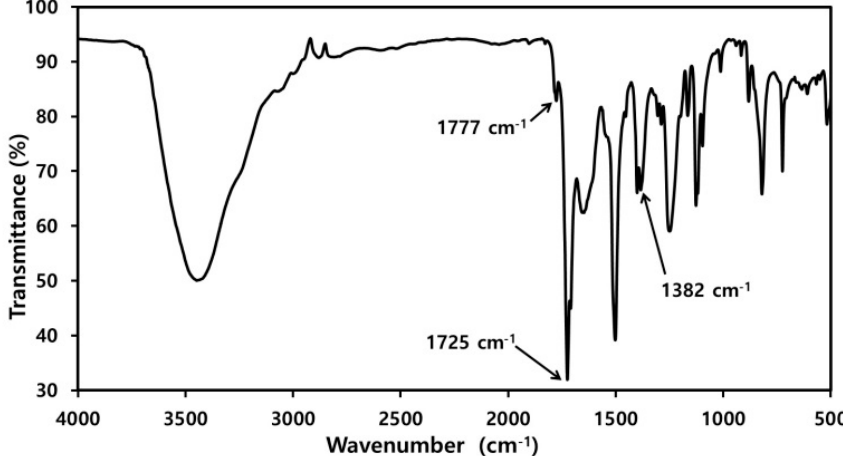
Figure 1. FT-IR spectrum of pyromellitic dianhydride-4,4 ′ -oxydianiline (PMDA-ODA) oligoimide.